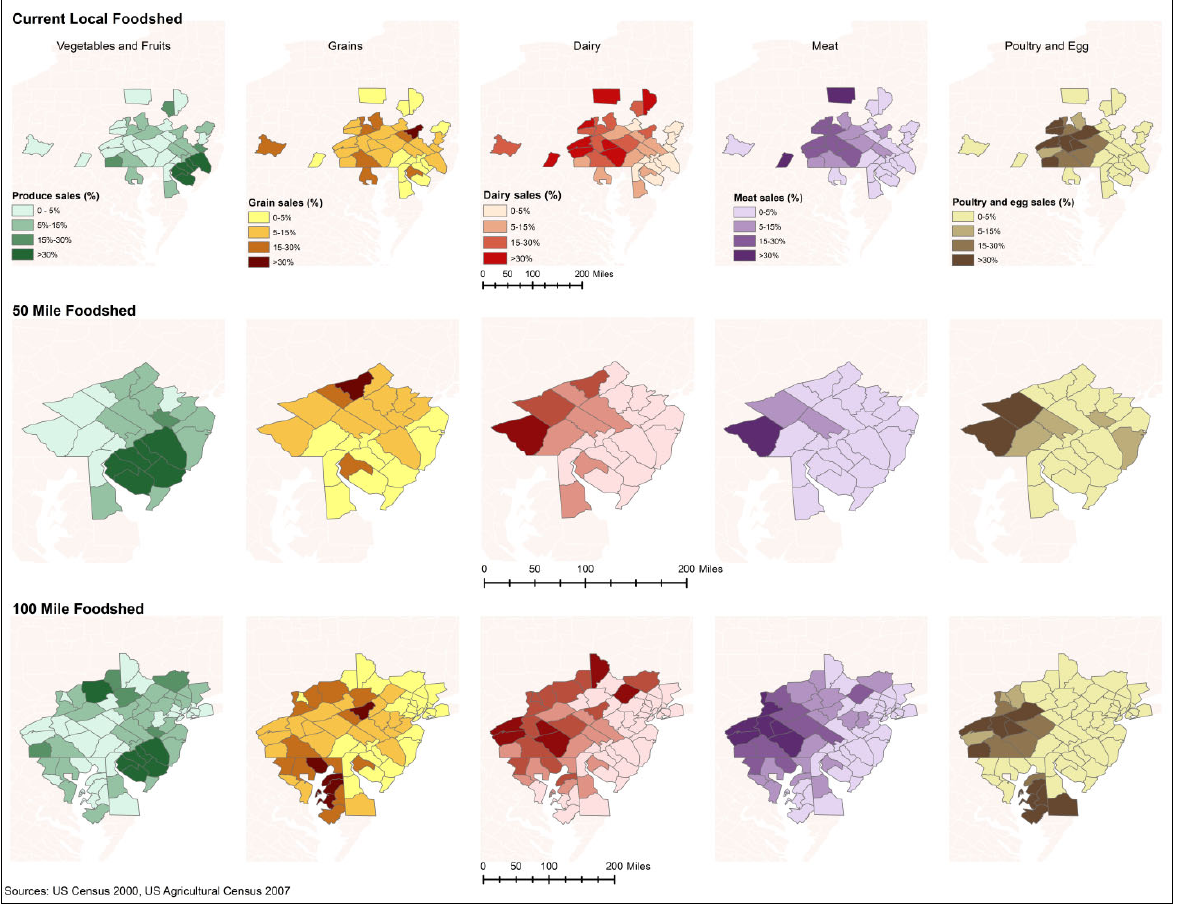
Figure 4. Agriculture Sales in Three Foodshed Regions by Product Group Maps represent percent of total sales for each agricultural product group within each